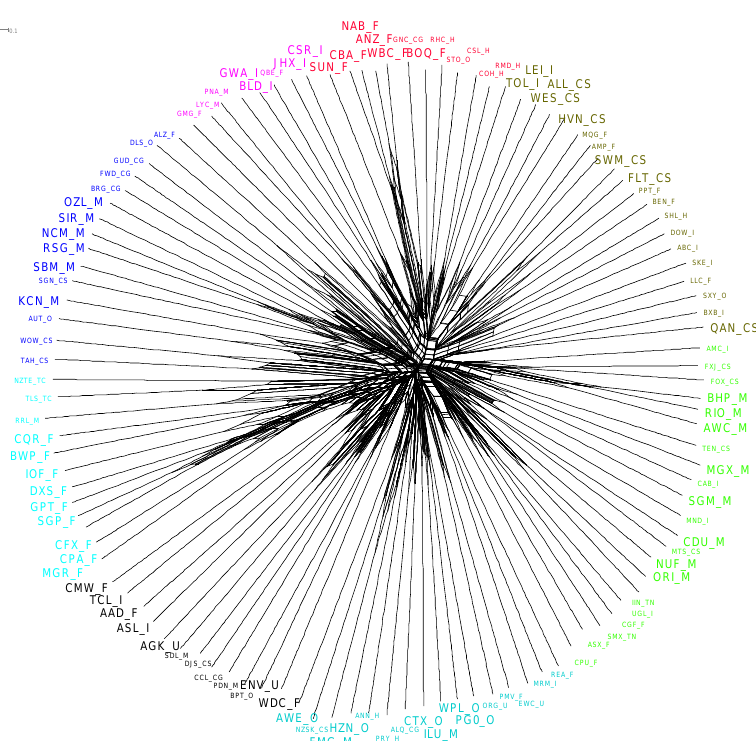
Figure 2. Period 1 neighbor-Nets splits graph with the clusters split into dominant and non-dominant industries. A one or two letter code has been appended to each stock’s three letter ticker symbol to indicate what industry group it belongs to using the codes assigned in Table 1.